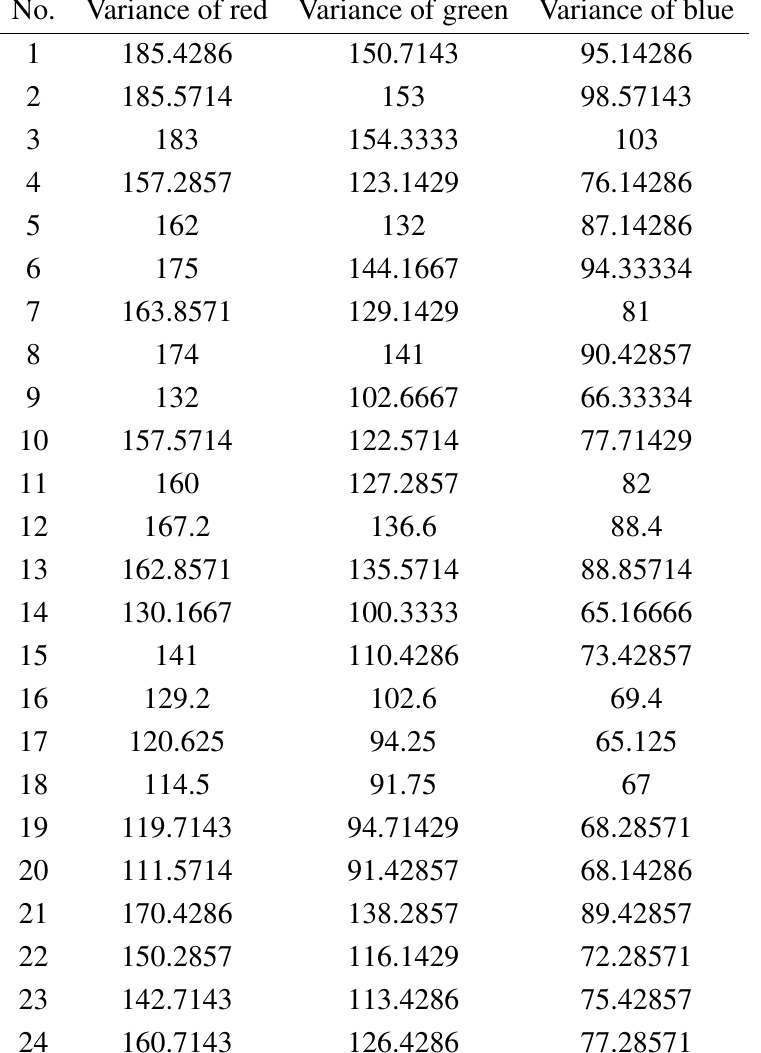
Table 2. Color features of some tobacco leaves (Dimensionless